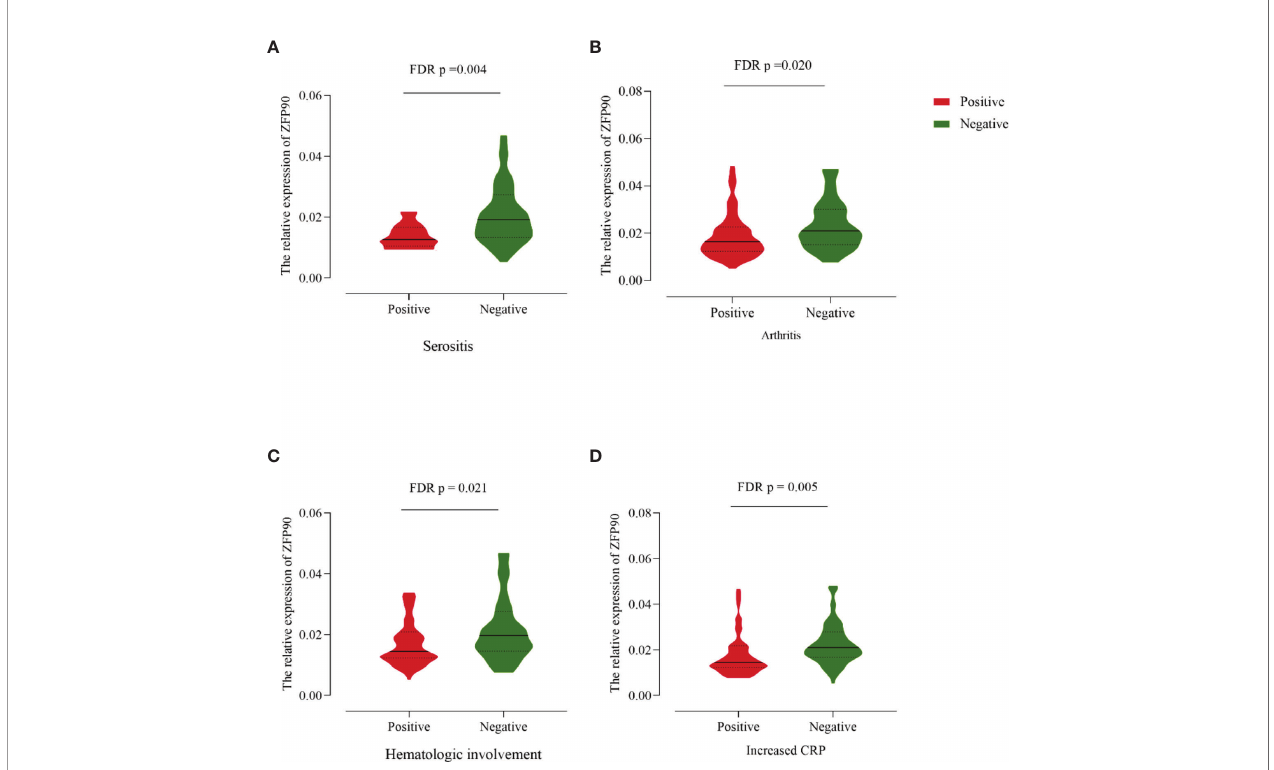
FIGURE 4 | (A) The ZFP90 mRNA expression levels were lower (FDR p = 0.004) in cases with serositis than those without. (B) The levels were lower (FDR p = 0.020) in cases with arthritis than those without. (C) The levels were lower (FDR p = 0.021) in cases with hematologic involvement than those without. (D) The levels were lower (FDR p = 0.005) in cases with increased CRP than those